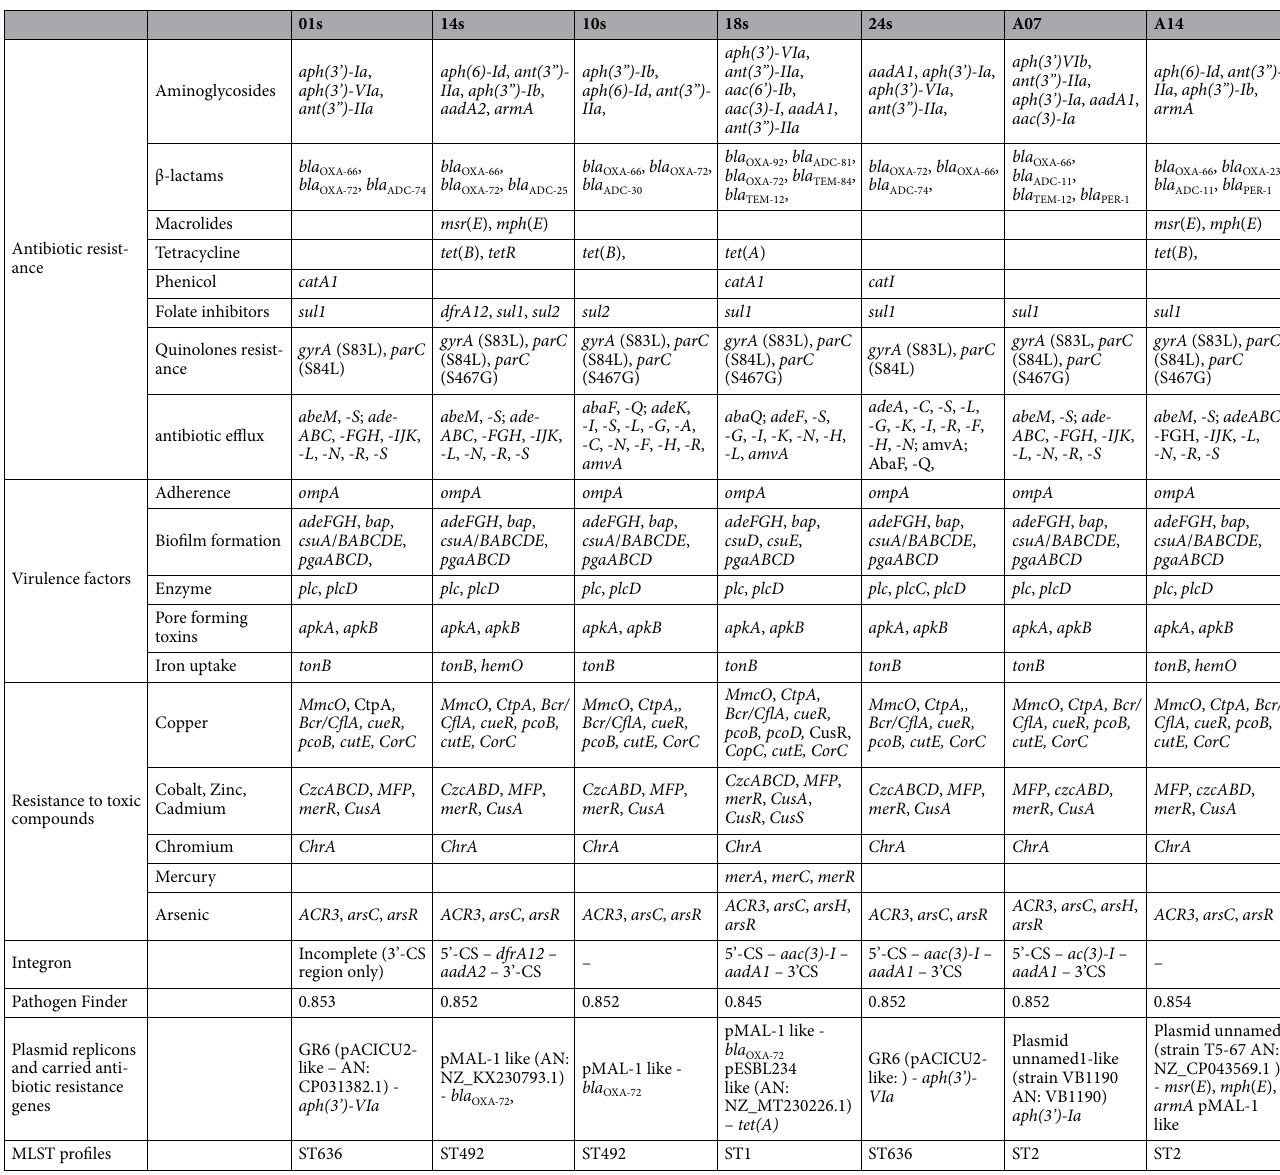
Table 3. AR and virulence genetic markers in the analyzed A. baumannii